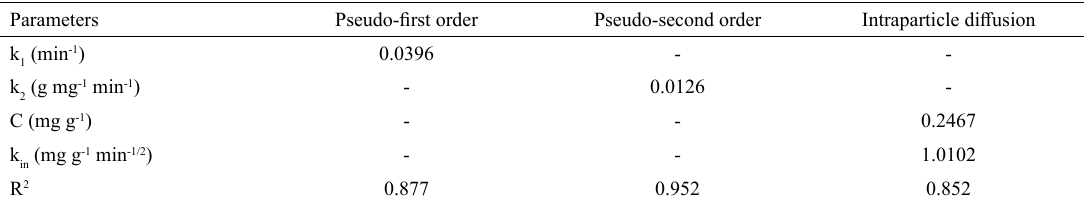
Figure 7. Experimental results of tetracycline adsorbed on the adsorbent as a function of time and adjust for models of pseudo-first order, the pseudo-second order (a) and the intraparticle diffusion (b) Table 2. Kinetic parameters of the kinetic model of pseudo-first order, pseudo-second order and intraparticle diffusion for tetracycline.